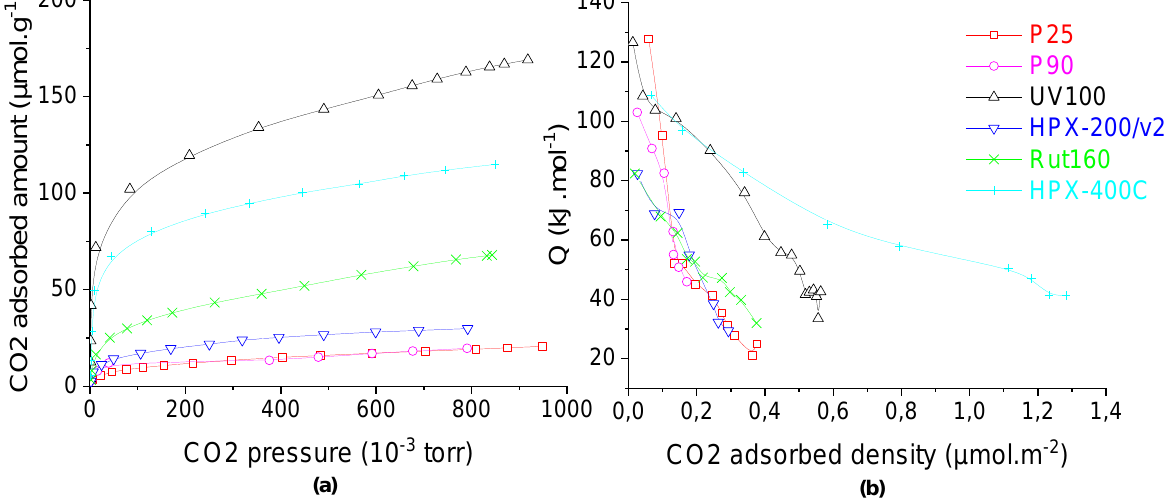
Figure 5. Carbon dioxide adsorption on TiO 2 ( a ) isotherms and ( b ) calorimetric curves. Conditions: TiO 2 samples pre-treated at 150 ◦ C under secondary vacuum for 5 h, CO 2 adsorption at 30 ◦